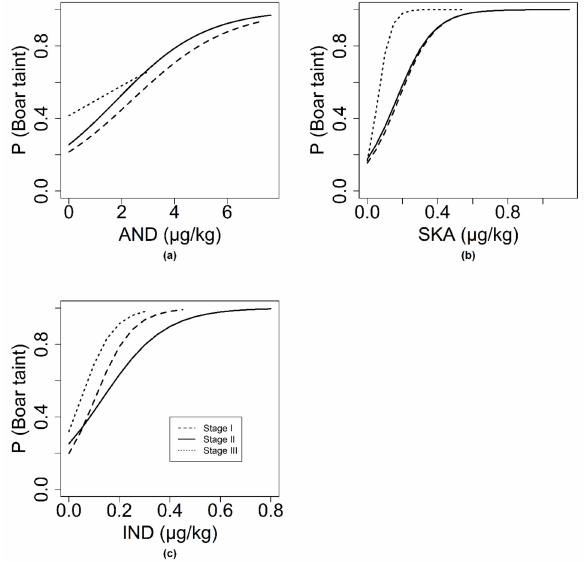
Figure 3. For a subset of entire male pigs, the link between boar taint compounds and the olfactory evaluation for the three stages of olfactory detection method optimization: ( a )For samples with SKA an IND under cuto ff , regression of P (Boar taint) as a function of AND. ( b ) For samples with AND an IND under cuto ff , regression of P (Boar taint) as a function of SKA. ( c )For samples with AND an SKA under cuto ff , regression lines of P (Boar taint) as a function of IND. P (Boar taint) indicated the odds that tainted sample be considered tainted by the olfactory